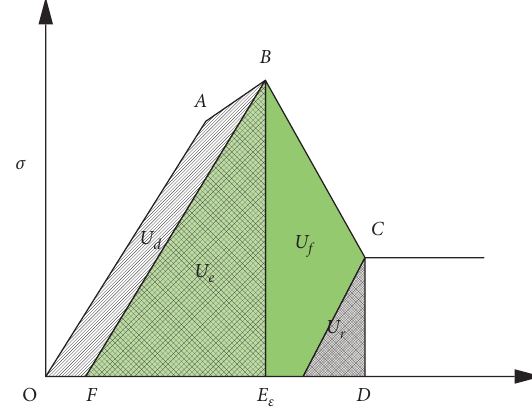
Figure 1: Strain energy evolution of rock in compression